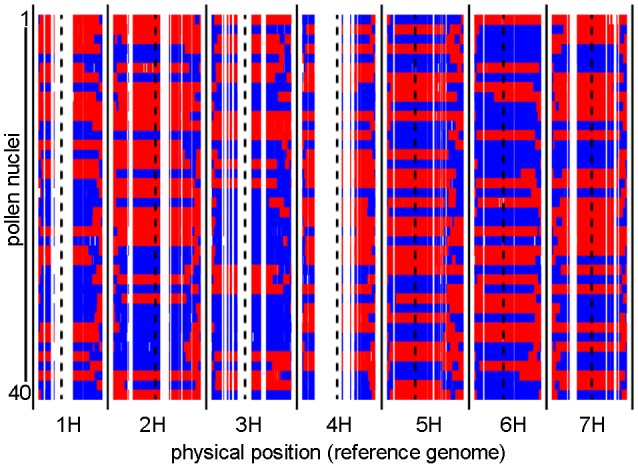
Graphical genotypes of individual pollen nuclei revealed by single-cell genome sequencing. Recombination events were detected in 40 individual pollen nuclei. The two parental barley genotypes are shown in red (“Morex”) and blue (“Barke”). Consensus genotypes were mapped to the physical reference genome of barley at 1 Mbp resolution. Centromere positions are indicated by dashed black lines. White gaps which consistently occur in all samples are regions where no genetic polymorphisms exist between “Morex” and “Barke.”